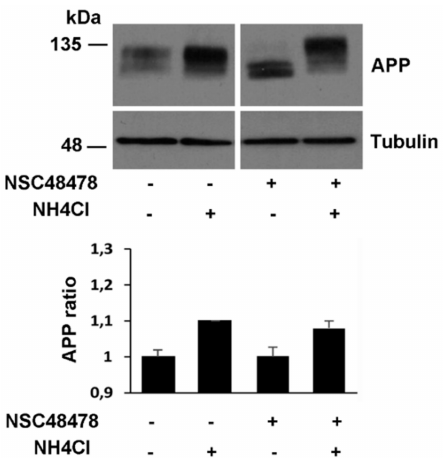
Figure 6. NH 4 Cl-induced acidification rescues inhibitor e ff ects on APP maturation. GT1 cells grown on dishes, were treated or not with the inhibitor NSC48478 in the presence or absence of NH 4 Cl (see methods). The cells were scraped in lysis bu ff er 1 and 40 µ g of total proteins were subjected to SDS-PAGE. APP and tubulin (as loading control) were revealed by Western blotting on PVDF and hybridization with A8717 and anti-tubulin Ab, respectively. Protein levels of APP were calculated by densitometric analysis with ImageJ software and expressed as a ratio, which was determined by imposing as 100% (ratio 1) the signal of APP in the untreated cells (lane 1). Mean ± SEM of three experiments were considered ( p < 0.05). All data were statistically significant. Plus ( + ) and minus (-) indicate the presence or absence of NSC48478 or NH 4 Cl.